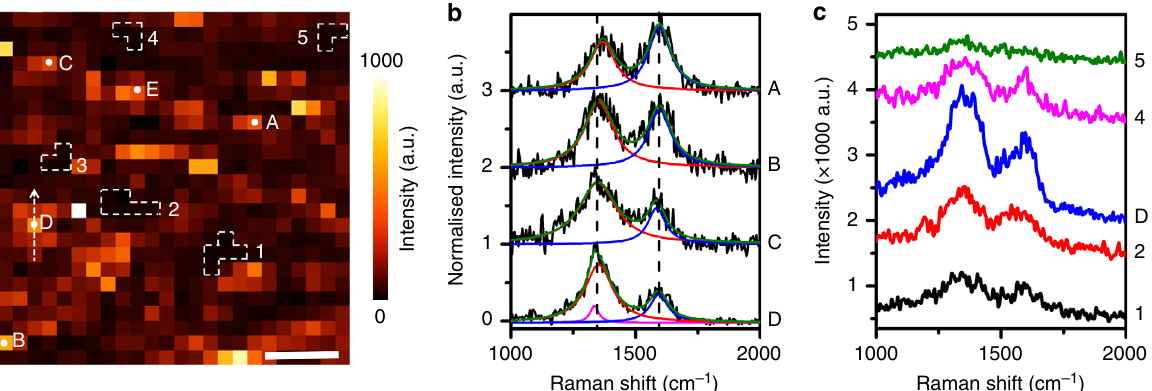
Fig. 3 Visualising structural defects and functional groups on the GO – COOH surface at the nanoscale. a Zoomed-in TERS map of D band intensity from 250 × 250 nm 2 area marked with a dashed square in Fig. 2c. Scale bar: 50 nm. b TERS spectra measured at the locations marked as A – D in ( a ). c TERS spectra measured at fi ve pixels along the arrow marked across location D in ( a ). Note that the area of the TERS map in ( a ) is only around 0.5 % of the diffraction limited laser spot area for our confocal Raman